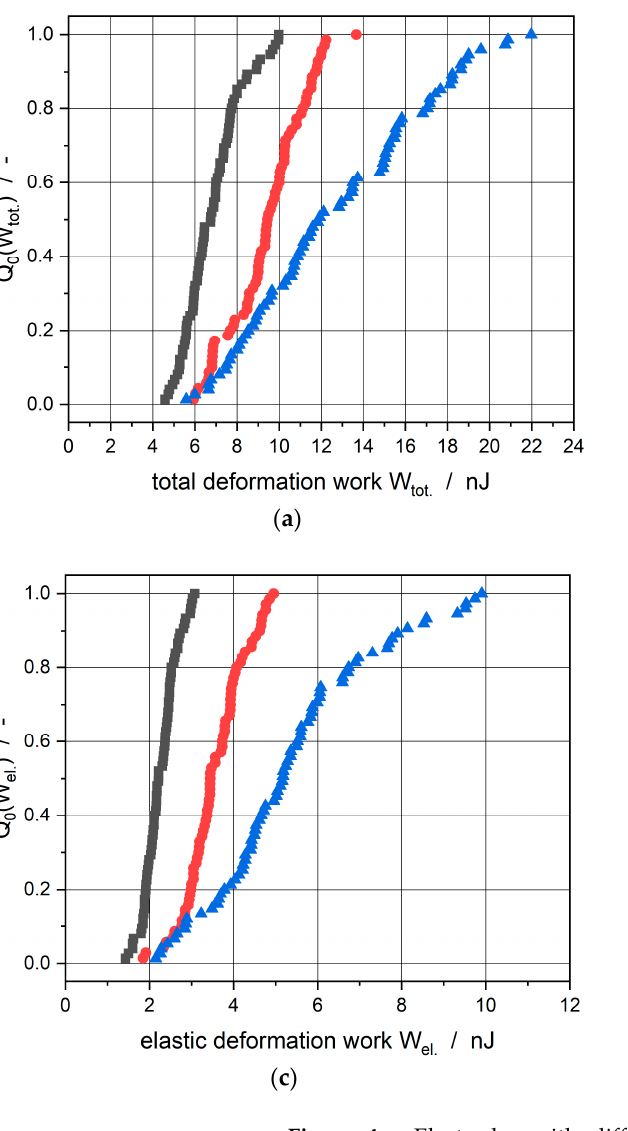
Figure 4. Electrodes with different active materials, mass loading ≈ 12 mg/cm 2 , coating density ≈ 1.00 g/cm 3 . ( a ) Total distribution of total deformation work; ( b ) total distribution of plastic deformation work; ( c ) total distribution of elastic deformation work; ( d ) total distribution of the ratio between plastic and elastic deformation work.